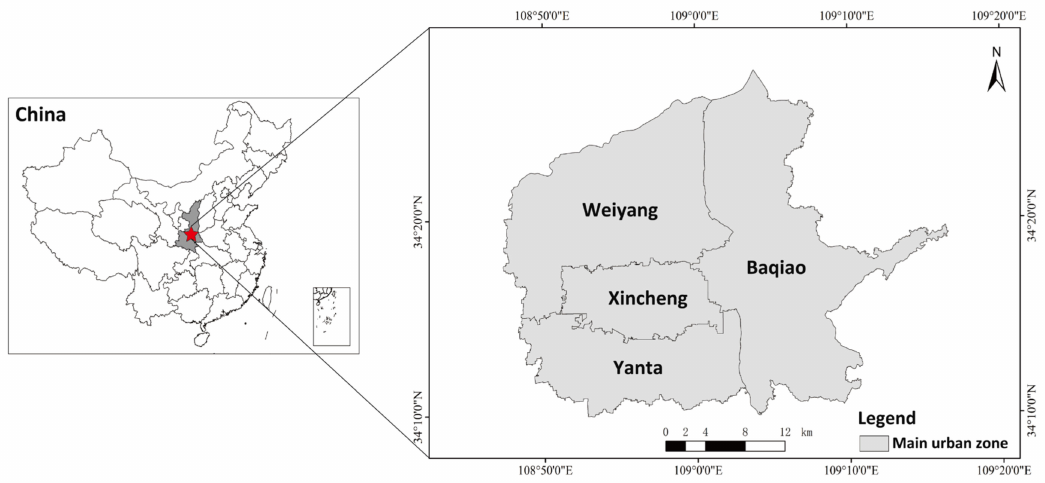
Figure 1. Location of the study